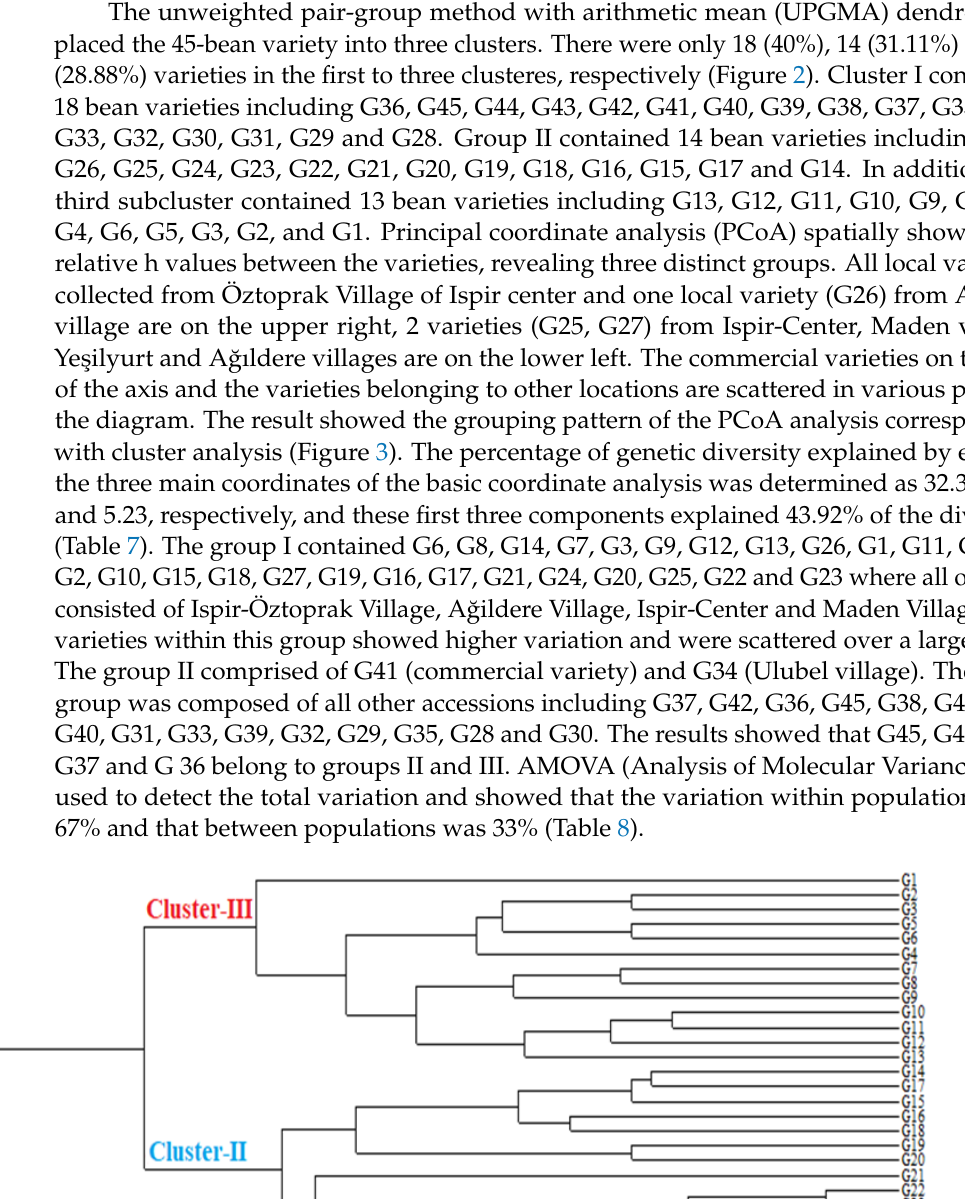
Figure 3. Principal coordinates analysis (PCoA) calculated from the pooled data of twenty-six inter- primer binding site (iPBS) primers in 45 bean varieties.